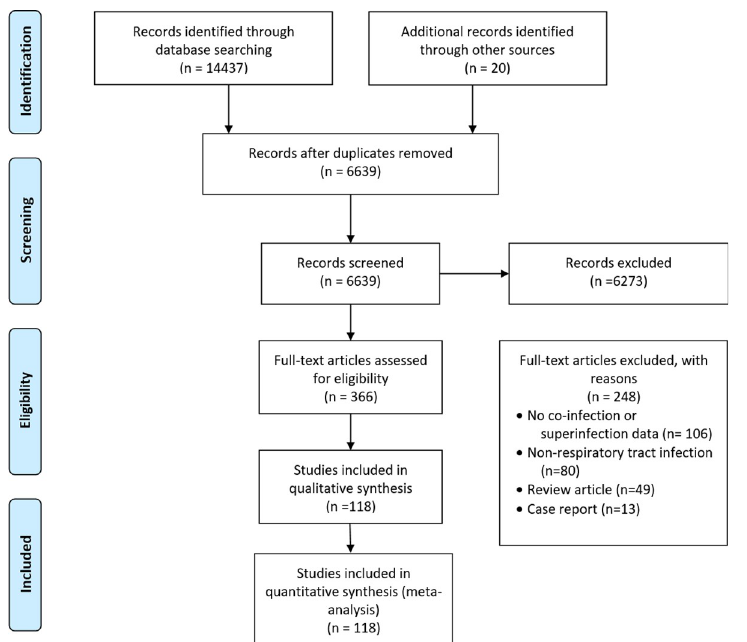
Fig 1. Study selection flow diagram: Adapted from the PRISMA guideline [11]. (Table 1). Seventy percent (83/118) of the studies reported data on antibiotic use. Of these, antibiotics were administered in 98% (81/83) of the studies.